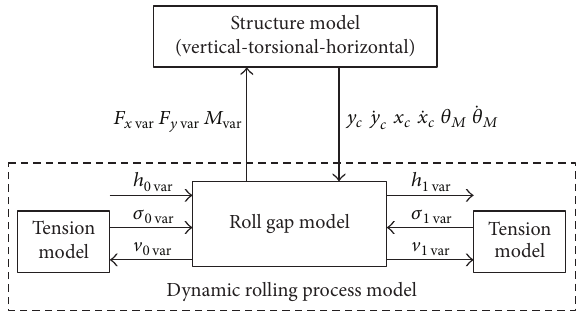
Figure 1: Coupling relationship of structural model and rolling process model.